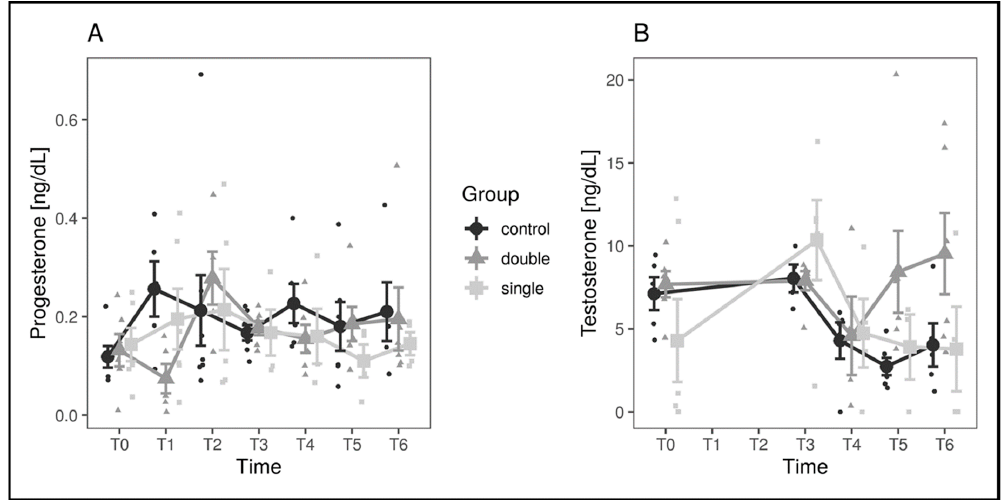
Figure 4. Hormone concentration values in the different experimental groups and across timepoints. Progesterone values are shown in panel ( A ), while testosterone values are shown in panel ( B ). Large dots represent means by group and timepoint, and vertical bars represent standard errors. Table 2. Mean, standard deviation, and median values for progesterone and testosterone concentration in all subjects from T0 (28 March 2019) to T6 (4 October 2019).